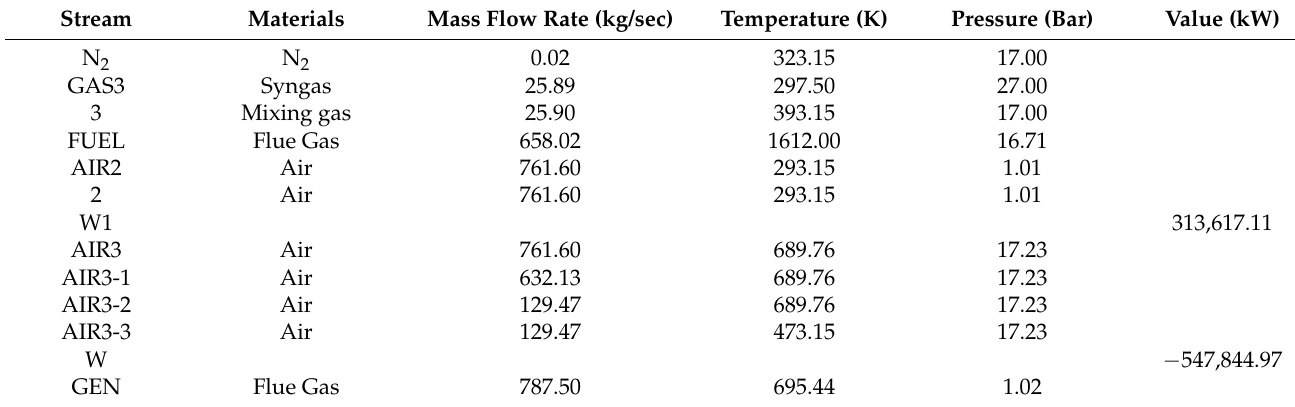
Table 7. Stream parameters in TURB.